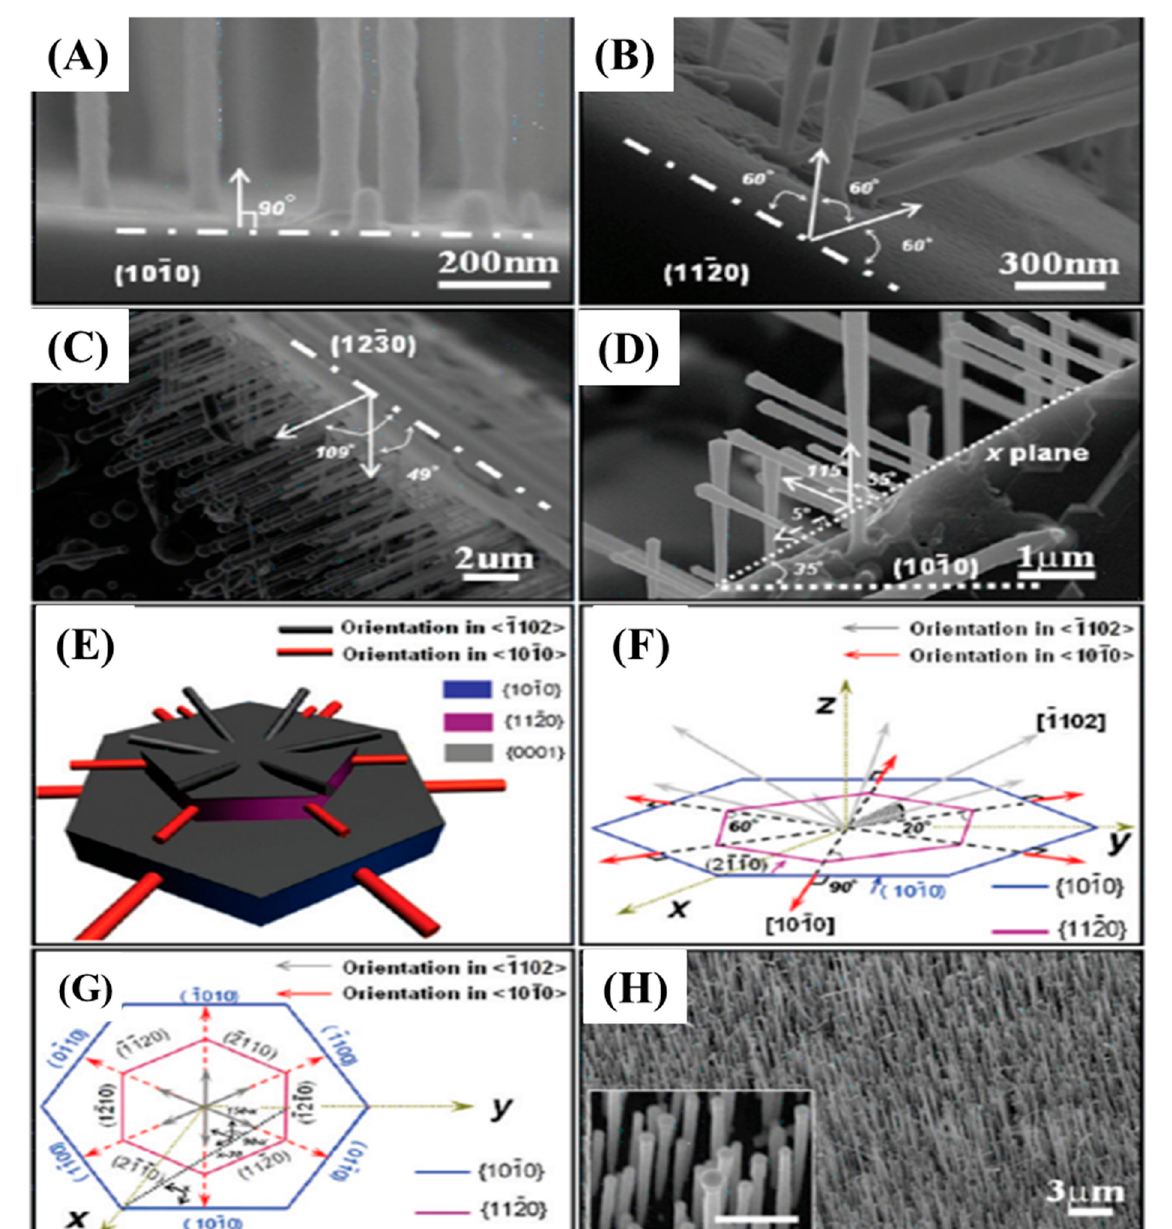
Figure 6. SEM images of SiC NWs grown on different SiC substrates ( A – C ). The dash and dot lines indicate the crystallographic planes of SiC substrates. SiC NWs were grown on x plane that is parallel to [0001] and with a tilted angle of 55 and 115 ◦ between the nanowire and substrate where x equals to 35 ◦ ( D ). The two dotted lines indicate x plane and tilt angle to X planes. A 3D model of NWs grown on SiC NWs on different planes ( E ). Pictorial representation indicating the relationships between substrate orientation and NWs axes ( F , G ). One well-aligned SiC NWs array fabricated on SiC substrate ( H ) [60]. Zhou et al. synthesized SiC-CDC NWs via a molten salt solution (CaCl 2 ) and a technique that useds SiO 2 and C powders as precursors at 900 ◦ C within and 3.1 V as indicated in Figure 7